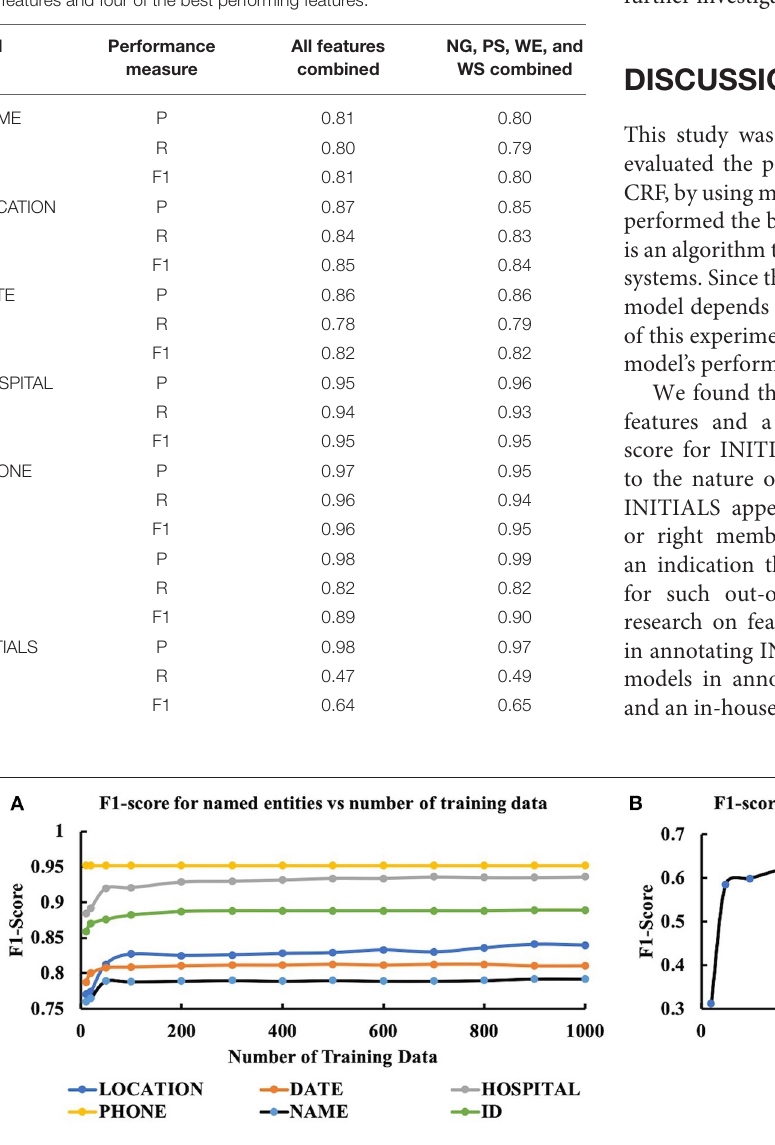
FIGURE 3 | Variation of performance (F1-score) of CRF model with the size of training data for (A) LOCATION, DATE, HOSPITAL, PHONE, NAME, ID, and (B) INITIALS.